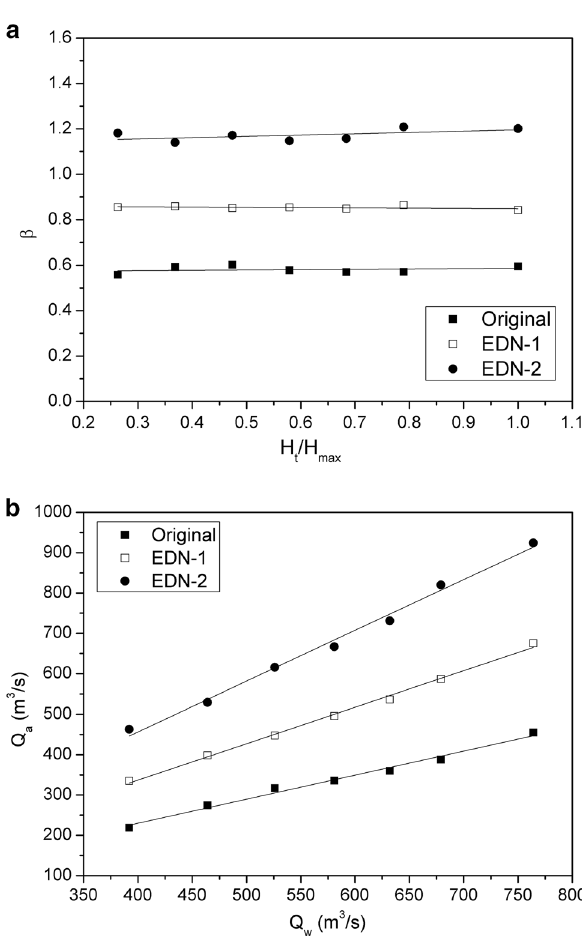
Fig. 13 Aeration performance of enhanced designs: a air entrainment rate versus dimensionless head, b air discharge versus water